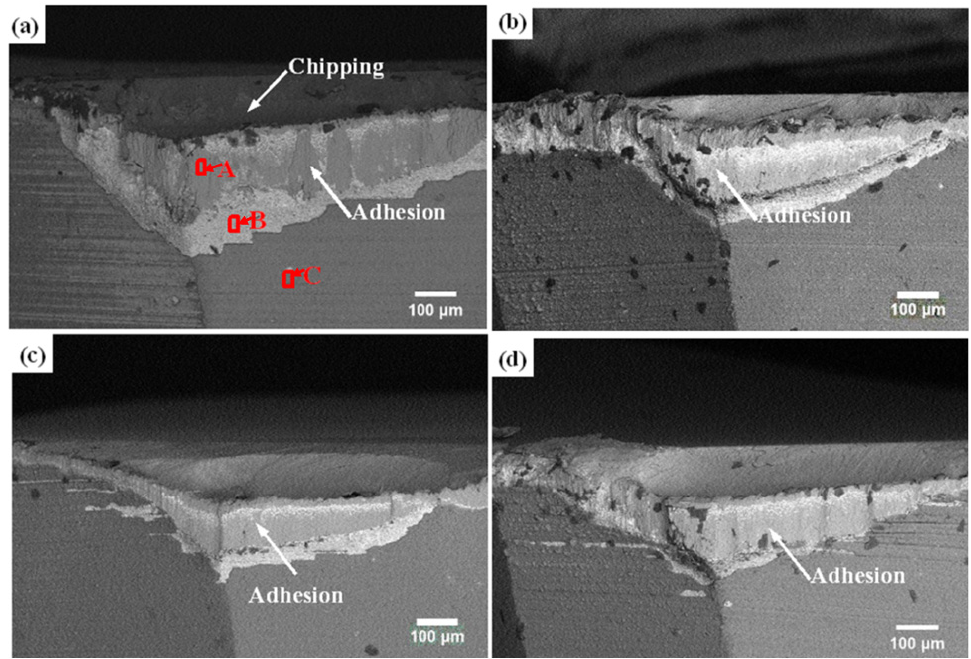
Figure 8. The worn flank face of ( a ) TiAlN/WT1, ( b ) TiAlN/WT2, ( c ) TiAlN/WT3 and ( d ) TiAlN/WT4 coated cemented carbides after TC4 turning.